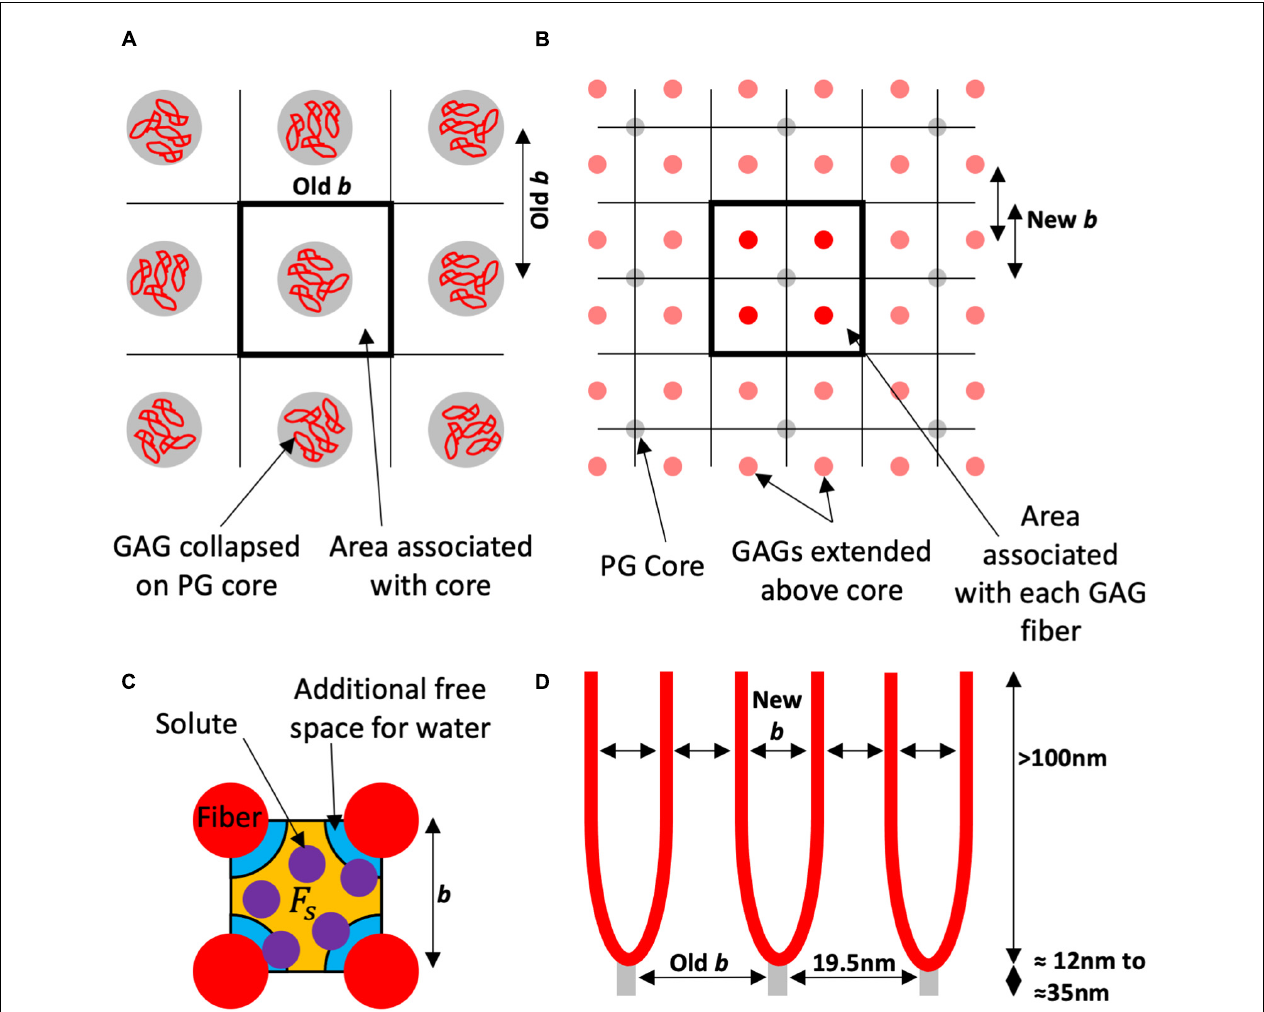
FIGURE 1 | Schematic of the proposed model using the square lattice example. (A) Looking to the wall from the lumen the electron microscopy visualizes the proteoglycan (PG) core protein with the glycosaminoglycan (GAG) fibers collapsed around them. This gives an inter-fiber spacing (Old b ) that has been measured experimentally as 19.5 nm, and an area associated with each fiber for the solvent and solute to pass. (B) The red GAG fibers (in this example four per core protein), are unraveled and spaced accordingly (in this case also into square ordering). Each fiber in this example has 1 4 of the associated area to the PG core protein, and a new spacing (New b ). (C) The orange free space ( F s ) for the purple solute is a proportion of the free space for water which has the orange and the additional blue space. The water is only excluded by the fiber diameter. This proportion is used to estimate the solute reflection coefficient. (D) Is a side view of the endothelial glycocalyx (eGlx) with the PG core protein spaced as “Old b ” or 19.5 nm. There is now a new spacing “New b ” between GAG fibers and a different fiber diameter to calculate the proportions of free space.